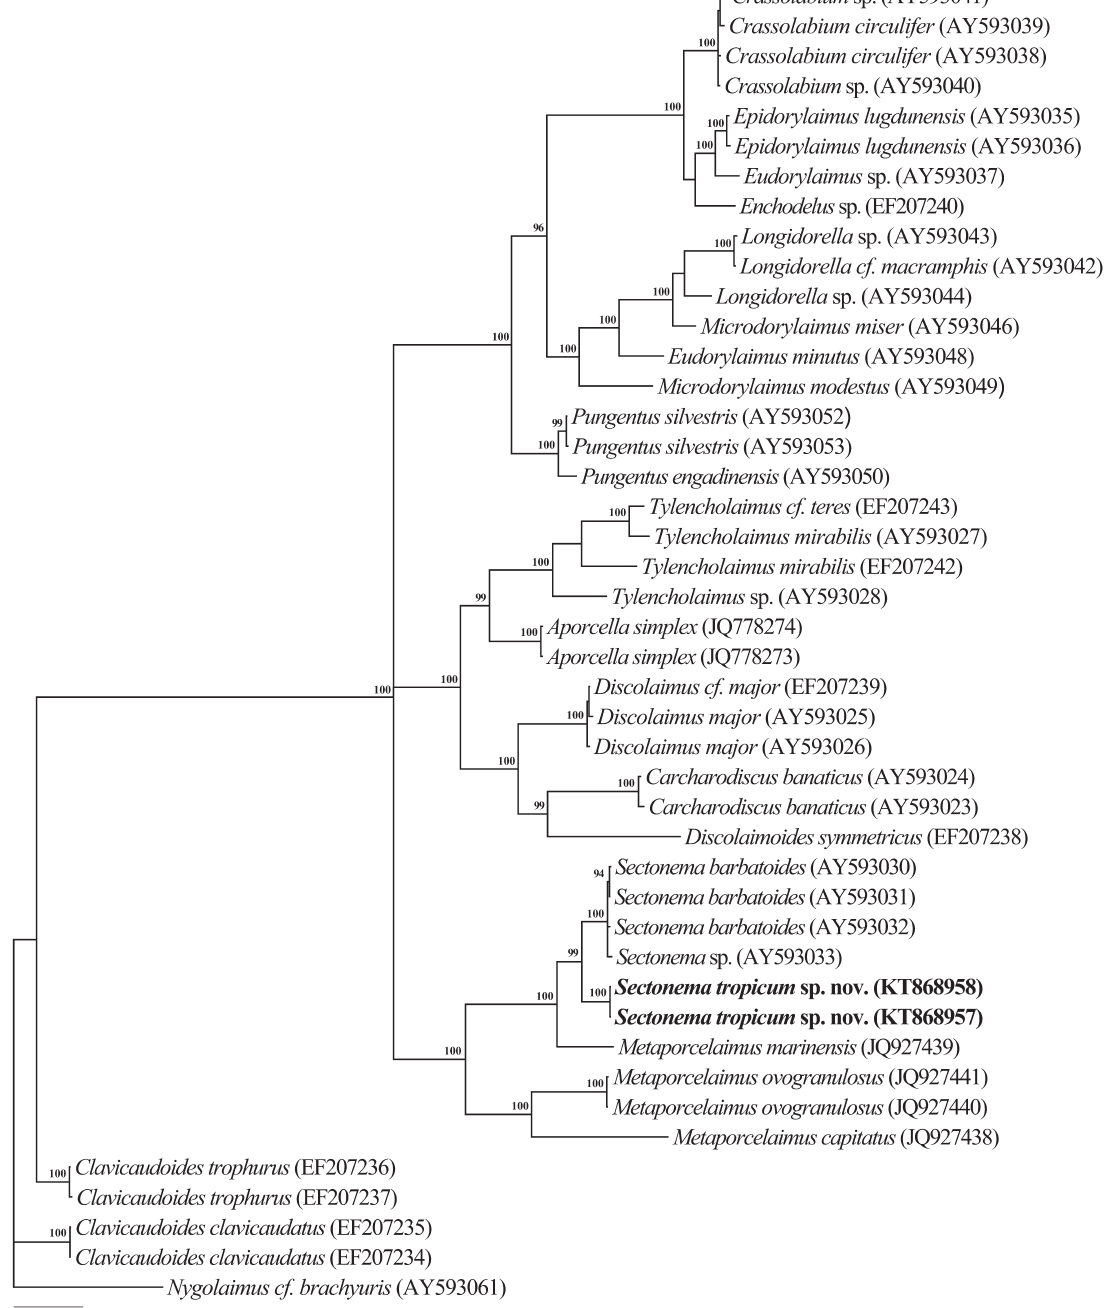
Fig. 5. Bayesian 50% majority rule consensus trees as inferred from D2–D3 expansion segments of 28S rRNA gene sequence alignments under the GTR + I + G model. Posterior probabilities are given for appropriate clades. Newly obtained sequences are indicated by bold